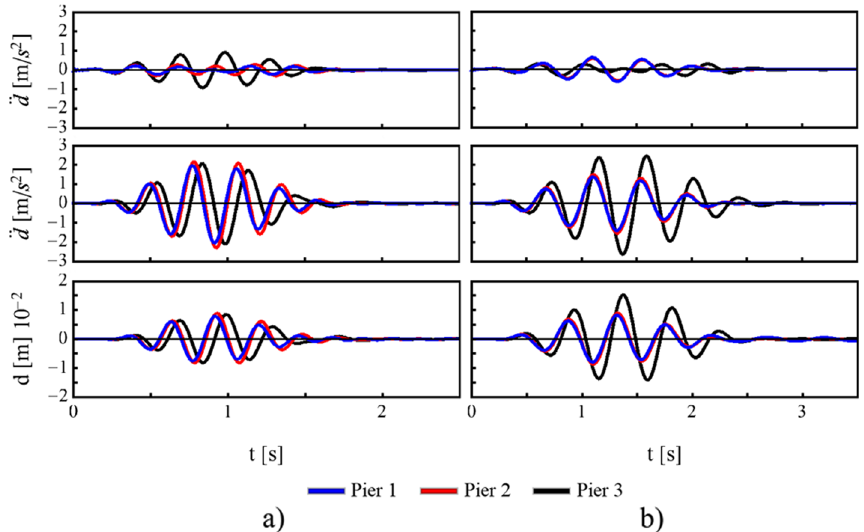
Fig. 8 Time history of the acceleration at the soil-bedrock interface (top) and pier base (middle) and of the displacement at the pier top (bottom), in the direction of the longitudinal axis of the bridge, for a predominant frequency of the input signal f q